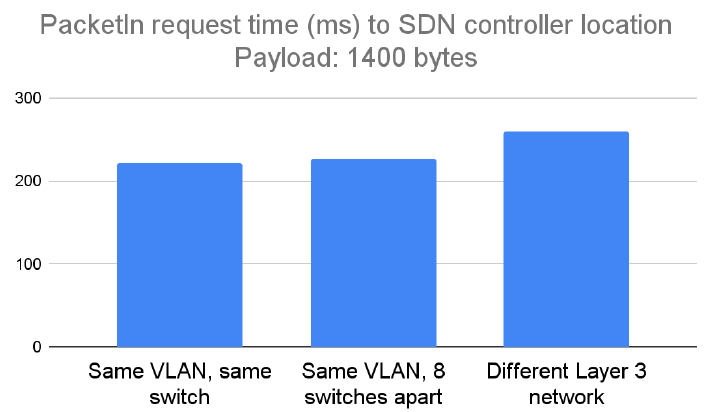
Figure 9. Experimental results of running the design for portability in case of a PacketIn packet having a payload of 1400 bytes, considered a large having a payload of 1400 bytes, considered a large payload.